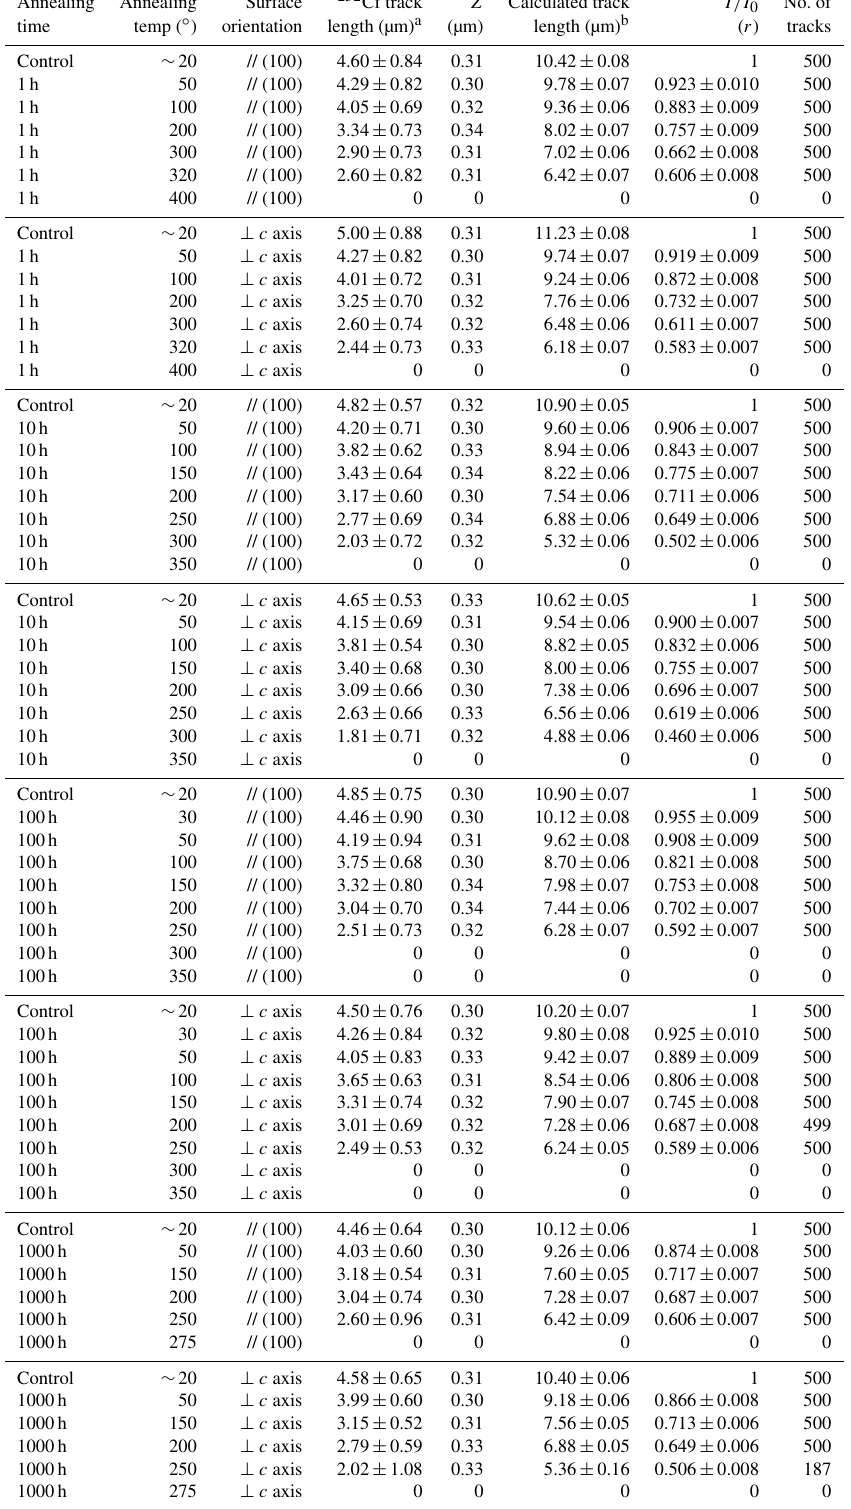
Table 3. Isochronal laboratory annealing data for 252 Cf tracks in the Harcourt granodiorite monazite (1 σ